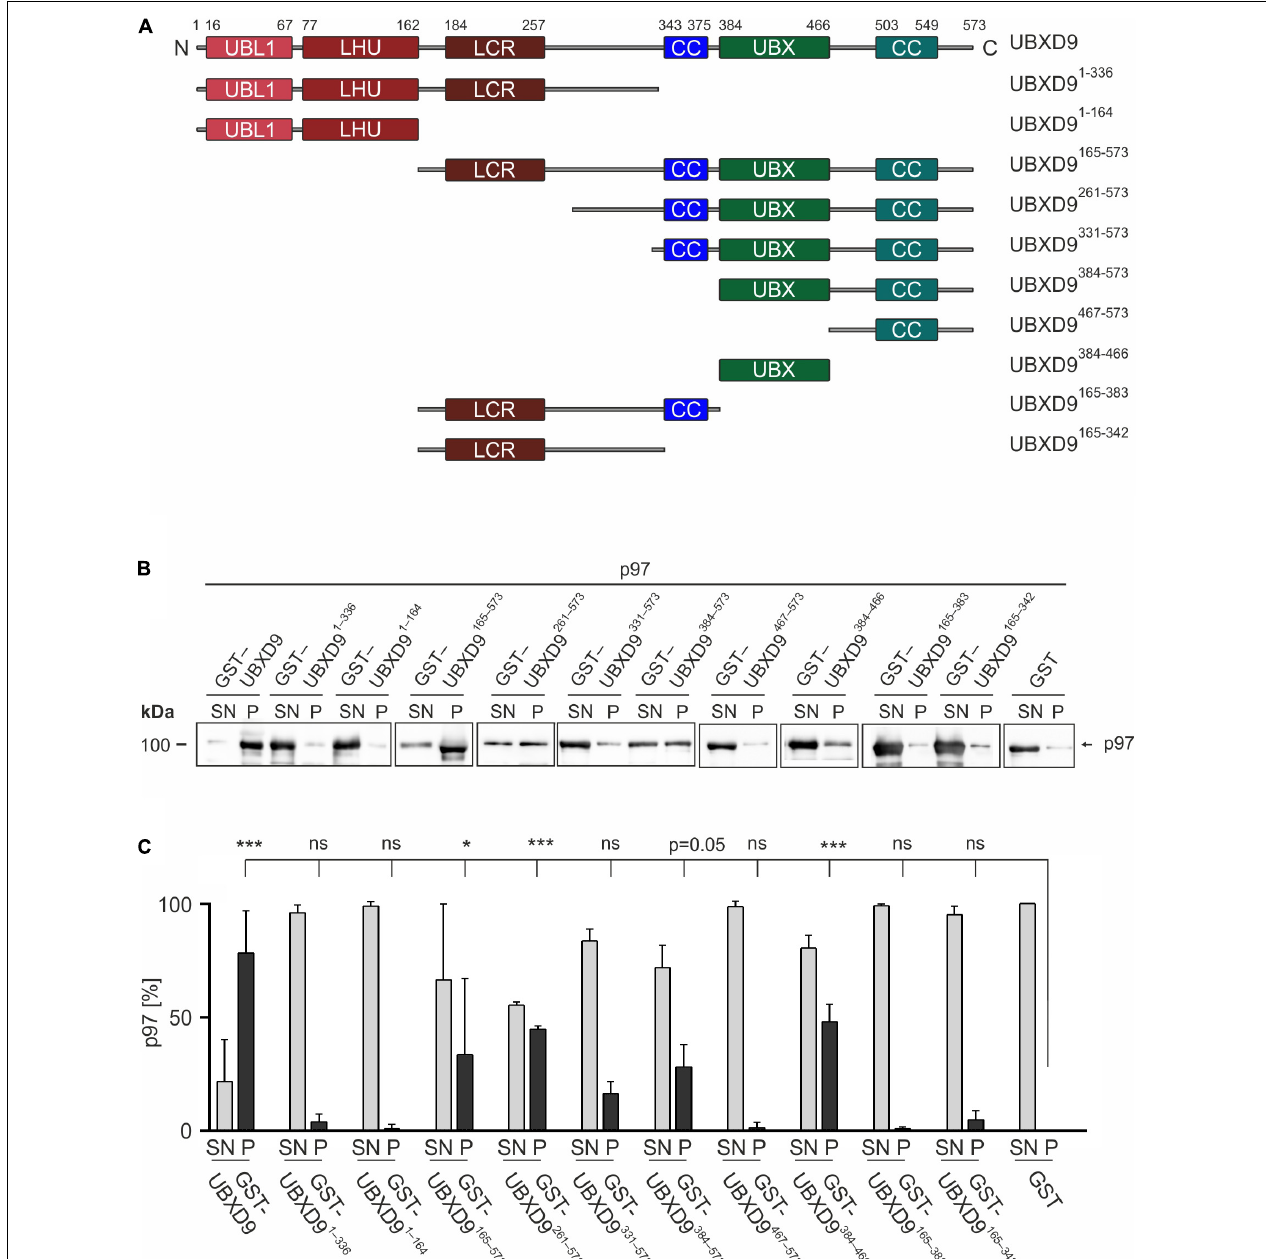
FIGURE 3 | The UBX domain is necessary and sufficient to bind to p97. (A) Schematic representation of the D. discoideum UBXD9 domain organization and of the analyzed UBXD9 truncation constructs. N, N-terminus; C, C-terminus; LCR, Low complexity region, UBL1, Ubiquitin-like domain 1; LHU, Low Homology UBX domain; CC, Coiled coil domain; UBX, Ubiquitin regulatory X domain. Numbers indicate amino acid positions of UBXD9. (B) Pull-down experiments with recombinant p97 and full-length or truncated GST-UBXD9 coupled to glutathione beads. GST coupled to glutathione beads was used as negative